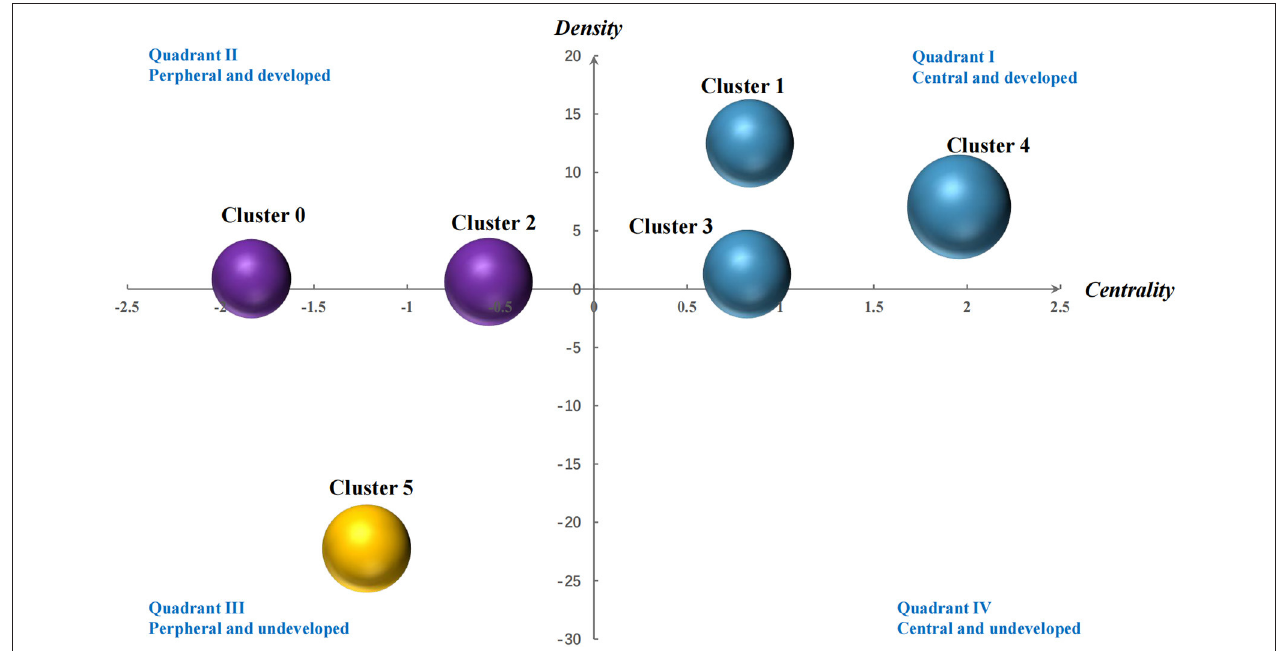
FIGURE 5 | Strategic diagrams for postpartum depression–related